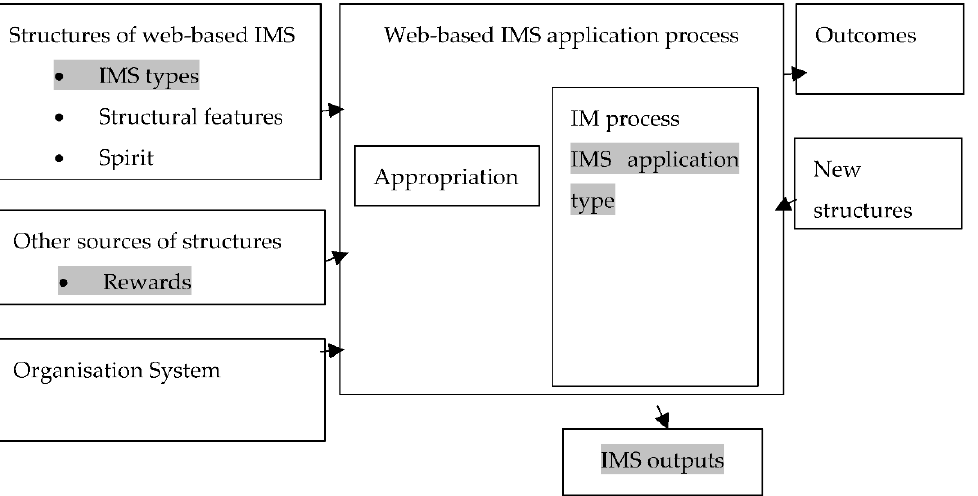
Figure 3. AST and web-based IMS.